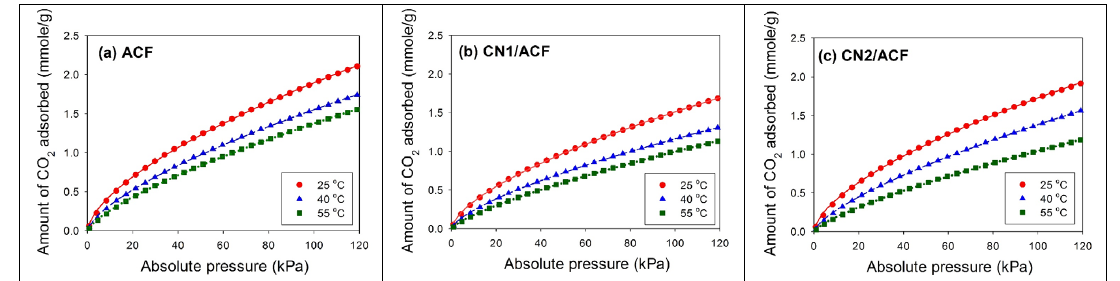
Figure 5. Adsorption isotherms of CO 2 on the samples at various temperatures: ( a ) as-received activated carbon fibers (ACF); ( b ) ACF grafted with N-doped carbon nanotubes (CN1/ACF); ( c ) ACF pre-immersed with cobalt(II) acetate and grafted with N-doped carbon nanotubes (CN2/ACF). The lines are the fitted curves by the Freundlich equation. Table 4. Comparisons of CO 2 adsorption in the present study with various supporting materials and modifications from the literature.